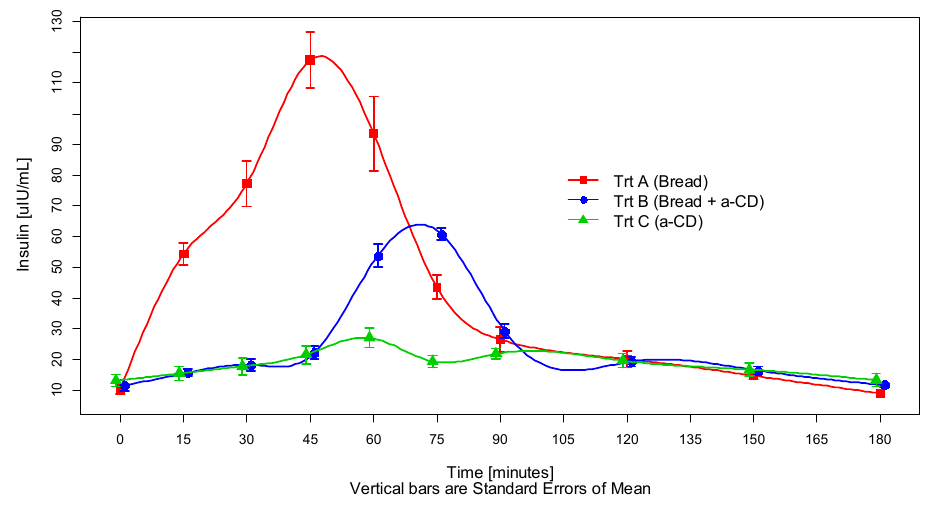
Figure 2. Insulinemic response curves elicited by 100 g white bread consumed with either 250 mL plain drinking water (treatment A), or 250 mL drinking water containing 10 g dissolved alpha-cyclodextrin (treatment B), or 250 mL drinking water containing 25 g dissolved alpha-CD only (treatment C). Values are the means of 12 subjects with their SEMs represented by vertical bars.